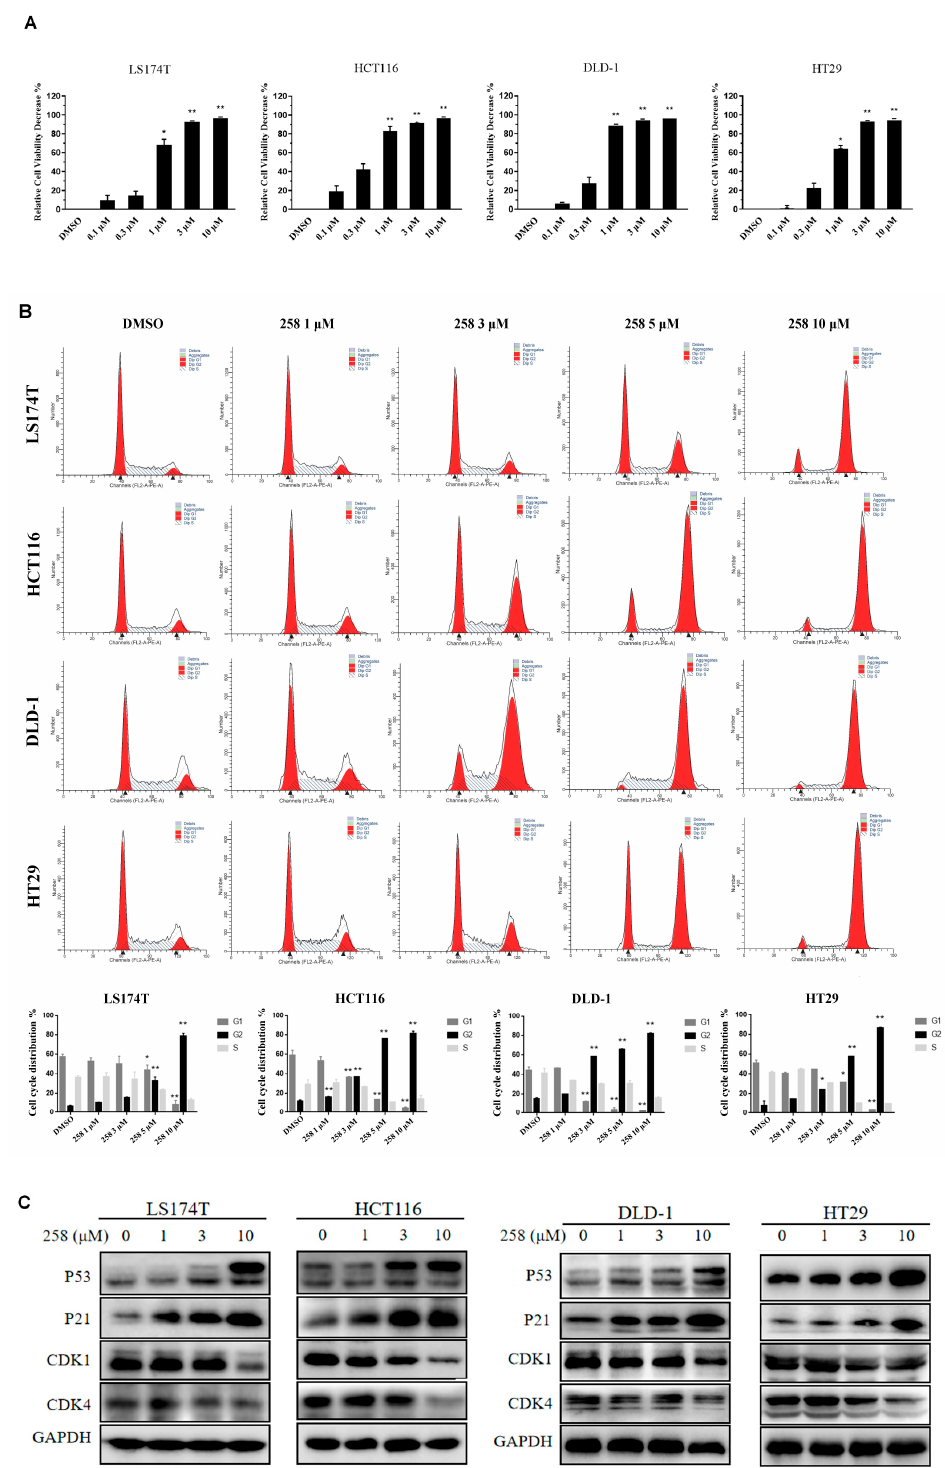
Figure 2. CX258 induced cell cycle arrest at the G2/M phase and inhibited CRC cell proliferation. ( A ) CX258 inhibited the proliferation of LS174T, HCT116, DLD-1 and HT29 CRC cells. Data are presented as the mean ± SD. * p < 0.05, ** p < 0.01. ( B ) CX258 induced the cell cycle arrest of CRC cells at the G2/M phase. The cell cycles were analyzed by PI staining and flow cytometry. Data are presented as the mean ± SD. * p < 0.05, ** p < 0.01. ( C ) CX258 induced P53 and P21 and inhibited CDK1 and CDK4 in CRC cells. The cells were treated with CX258 or DMSO for 24 h. GAPDH was used as a loading